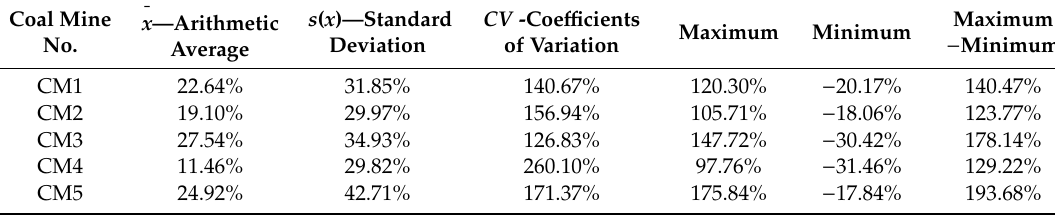
Table 8. Descriptive statistics for financial e ffi ciency in examined coal mines (CM) (in